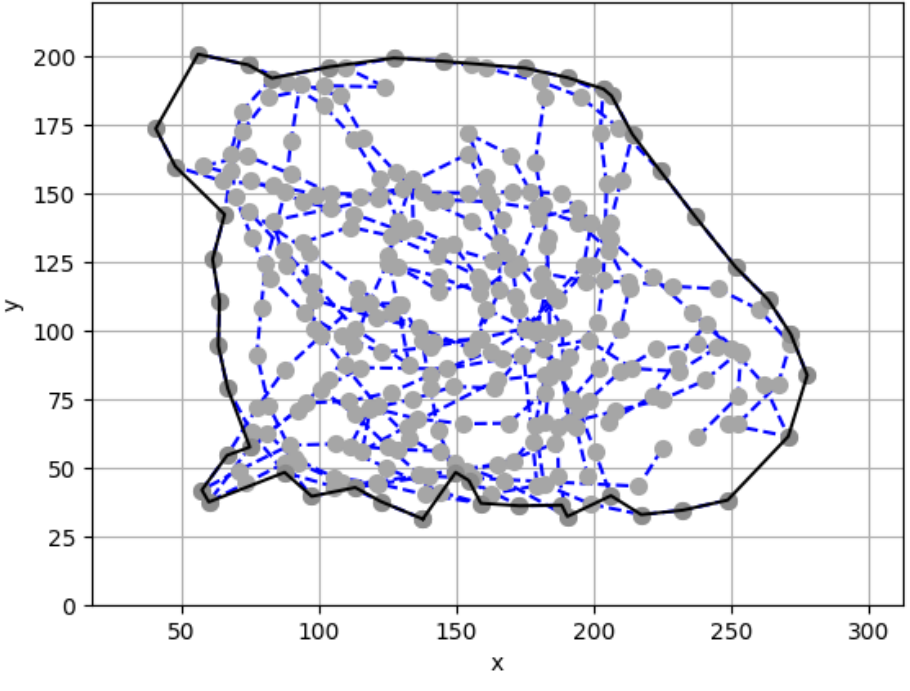
Figure A2. Number of Points visualization example. Quadrant point count: The consultation room was divided into four quadrants of equal size, numbered as in Figure A3. Let PQ i denote the number of points of a dog’s trajectory belonging to quarter i